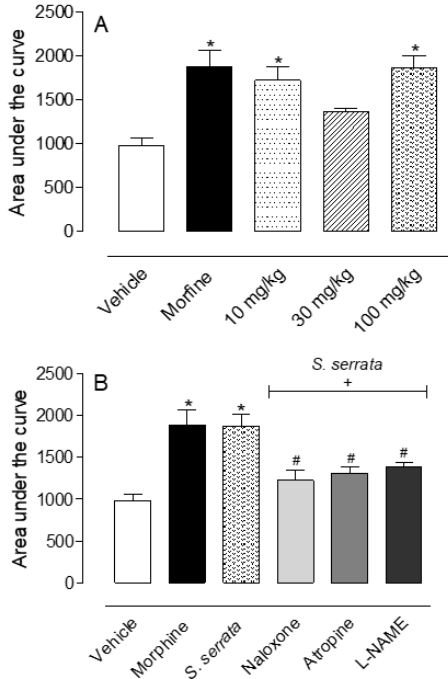
Figure 2. Effects of essential oil of Stevia serrata and different antagonists in the thermal nociception model (hot plate). The mice were pretreated orally with the vehicle, essential oil (10, 30, 100 mg / kg) or morphine (2.5 mg / kg) and nociceptive e ff ect was evaluated in the hot plate model ( A ). The animals have been pretreated with naloxone (1 mg / kg, i.p.), atropine (1 mg / kg, i.p.) or L-NAME (3 mg / kg,